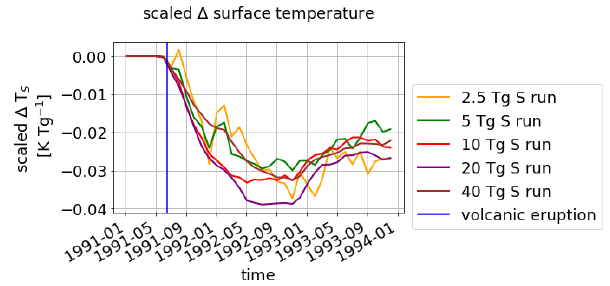
Figure A2. Scaled surface temperature for the five volcanically per- turbed EVAens runs (2.5, 5, 10, 20 and 40Tg S). The ensemble means are shown. The vertical blue line marks the eruption time. All surface temperatures are divided by the mass of emitted sulfur.